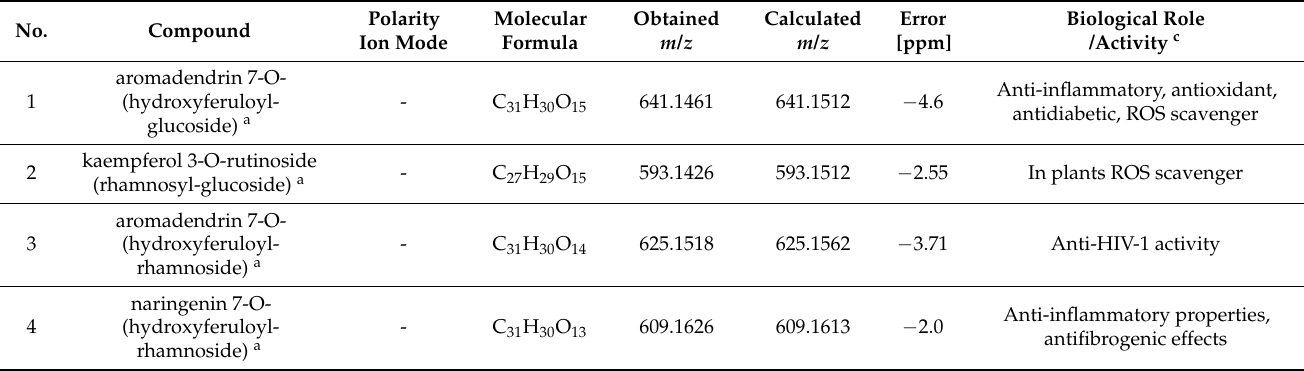
Table 2. Flavonoids identified with LC-MS. List of flavonoids, including polyphenol and their biological activity identified in post-culture medium of the Cyathea delgadii cell